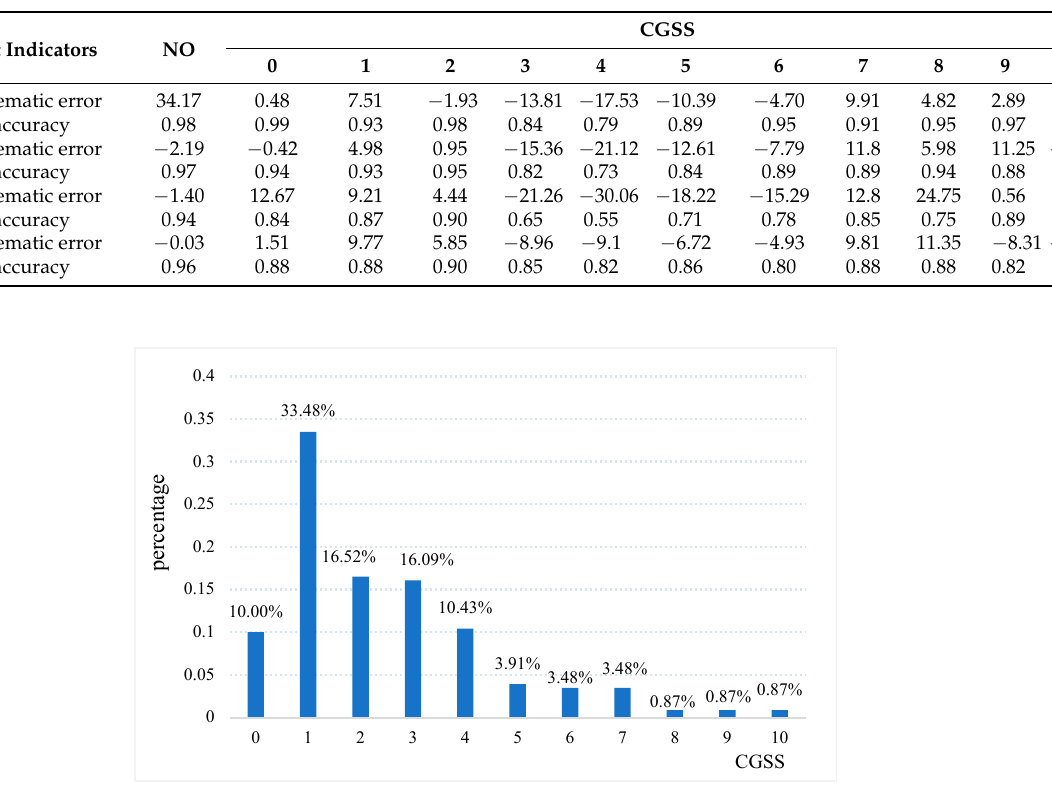
Table 7. Test indicators of morphological–structural growth model of Chinese fir based on CGMSS.